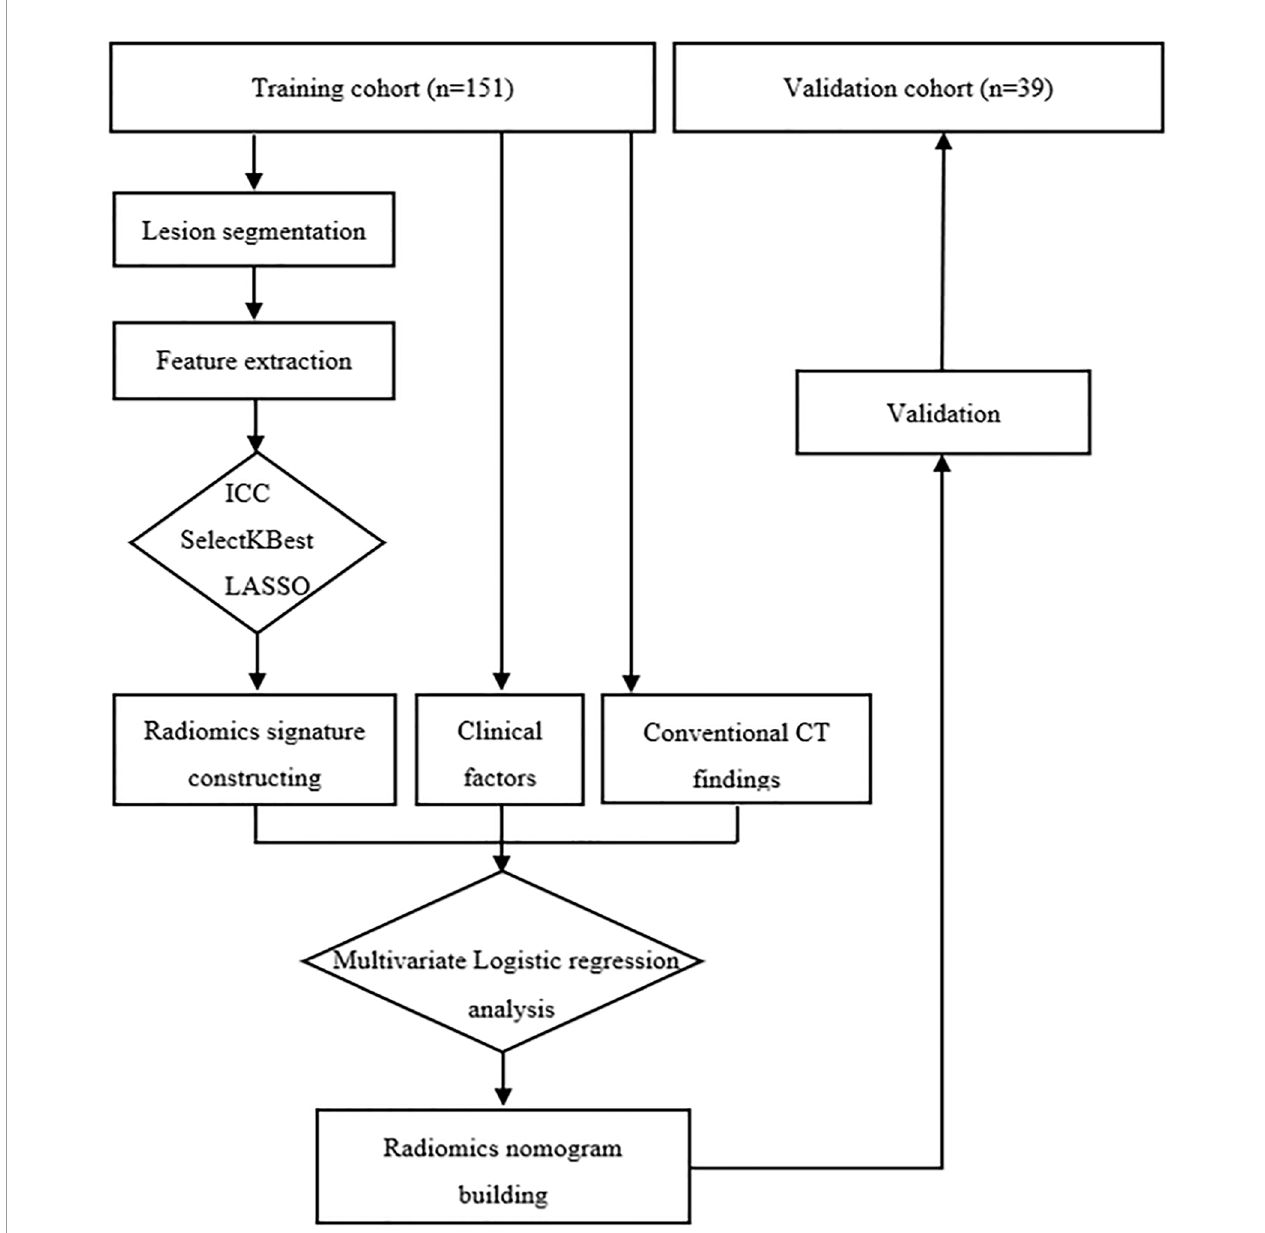
FIGURE 2 | Radiomics work fl ow of the